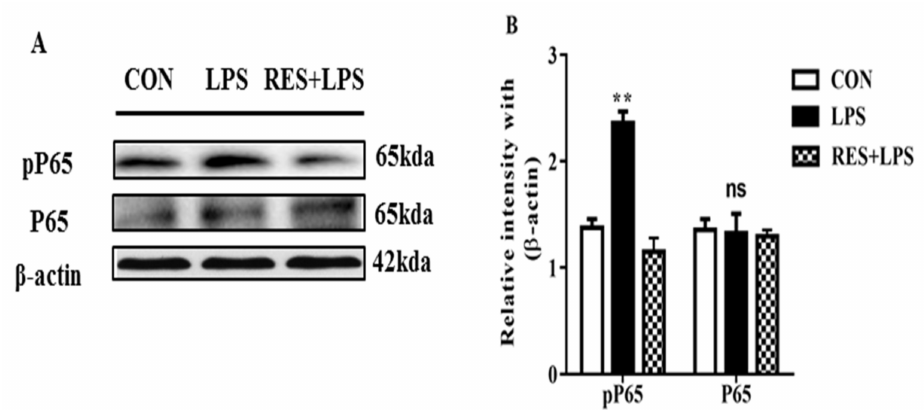
Figure 6. ( A ) Immunoblots and ( B ) quantification of pP65 and P65 in LPS in comparison with CON and RES+LPS groups. ns: not significant and ** p < 0.005 highly